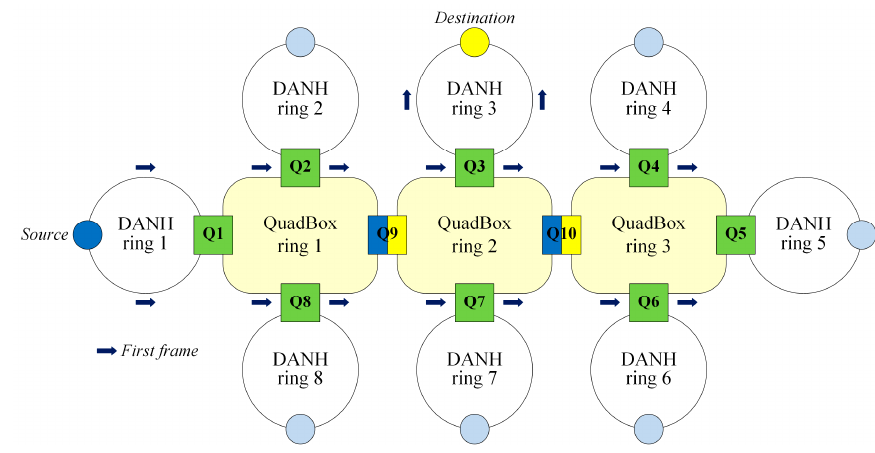
Figure 9. The process of the setting step.